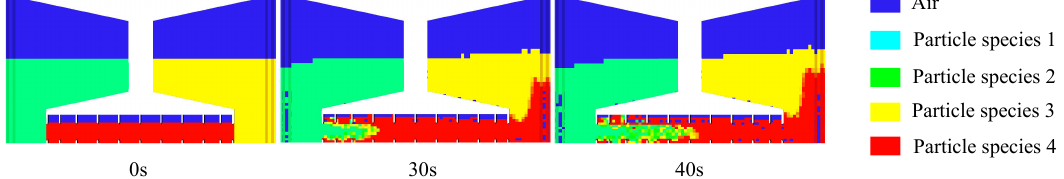
Figure 7. Coloured particle species distributions at the times of 0, 30 and 40 s, demonstrating approximate plug flow in the